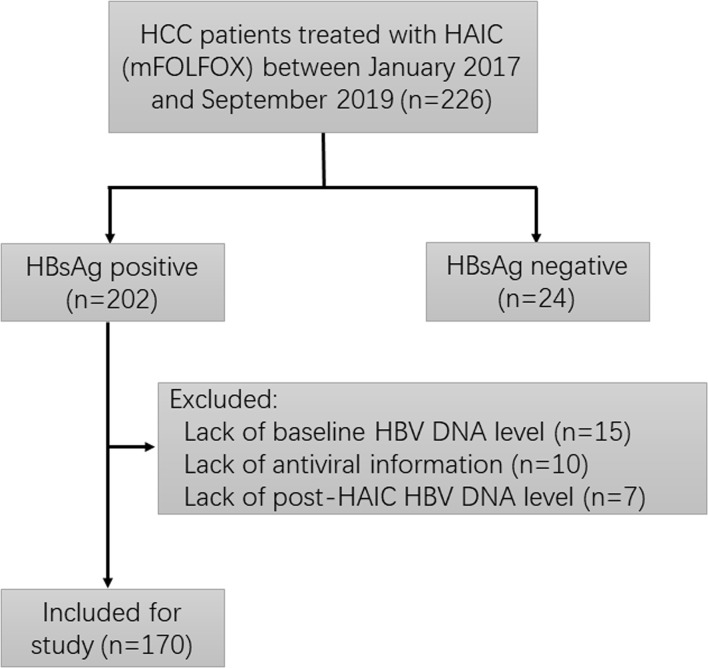
Flowchart depicting patient deposition. HCC, hepatocellular carcinoma; HAIC, hepatic artery infusion chemotherapy; HBsAg, hepatitis B surface antigen; HBV, hepatitis B virus.